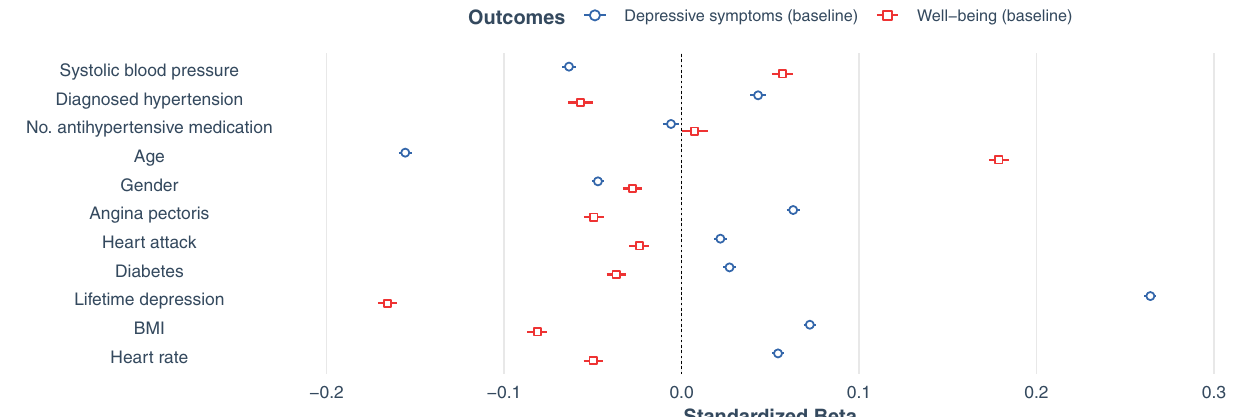
Fig. 2 | Cross-sectional associations with mental health outcomes at initial assessment. Forest plot shows standardized beta estimates and 95% con fi dence intervals for predictors of interest (systolic blood pressure, diagnosed hyperten- sion (HTN), and number of antihypertensives) as well as covariates. There were